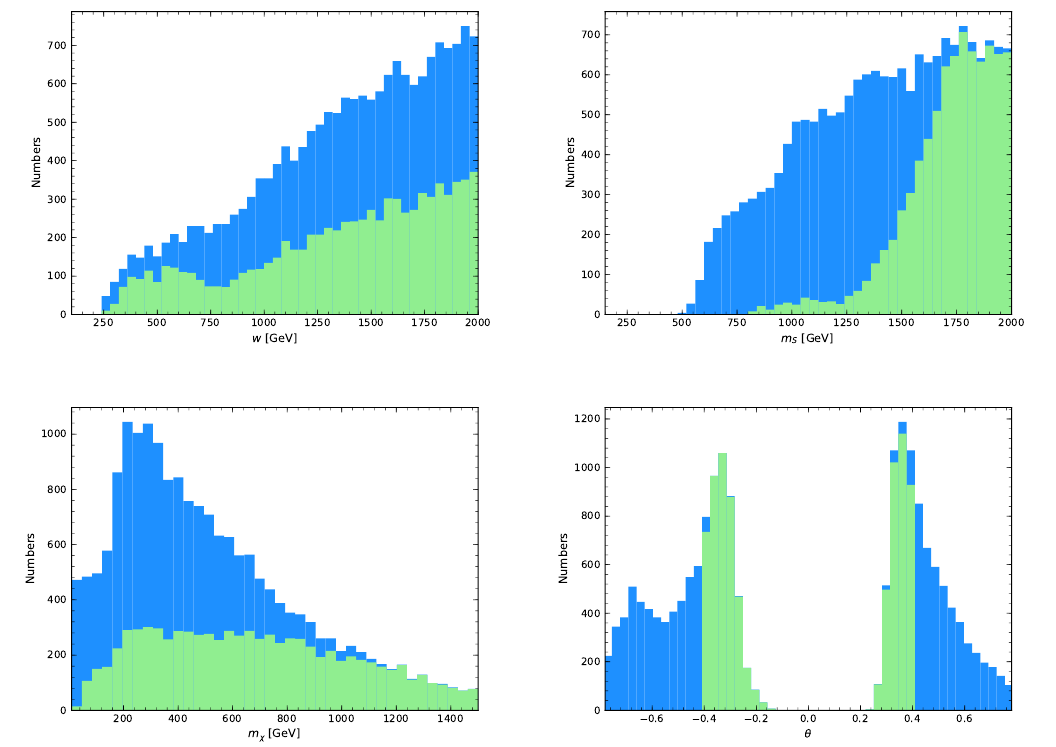
Figure 8 . Distributions of the input parameters. The blue histogram represents those samples that can trigger a strong EWPT, the green histogram represents those samples that further survive the experimental